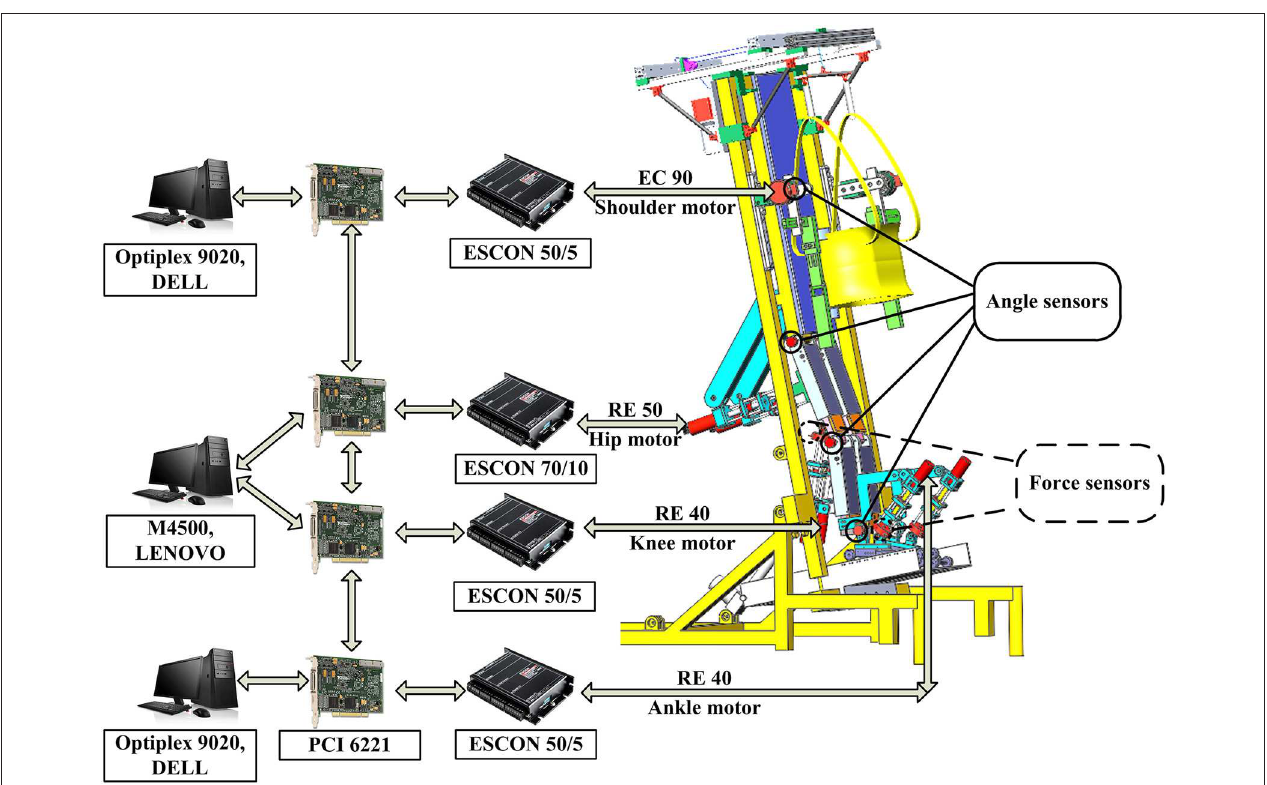
FIGURE 3 | Control